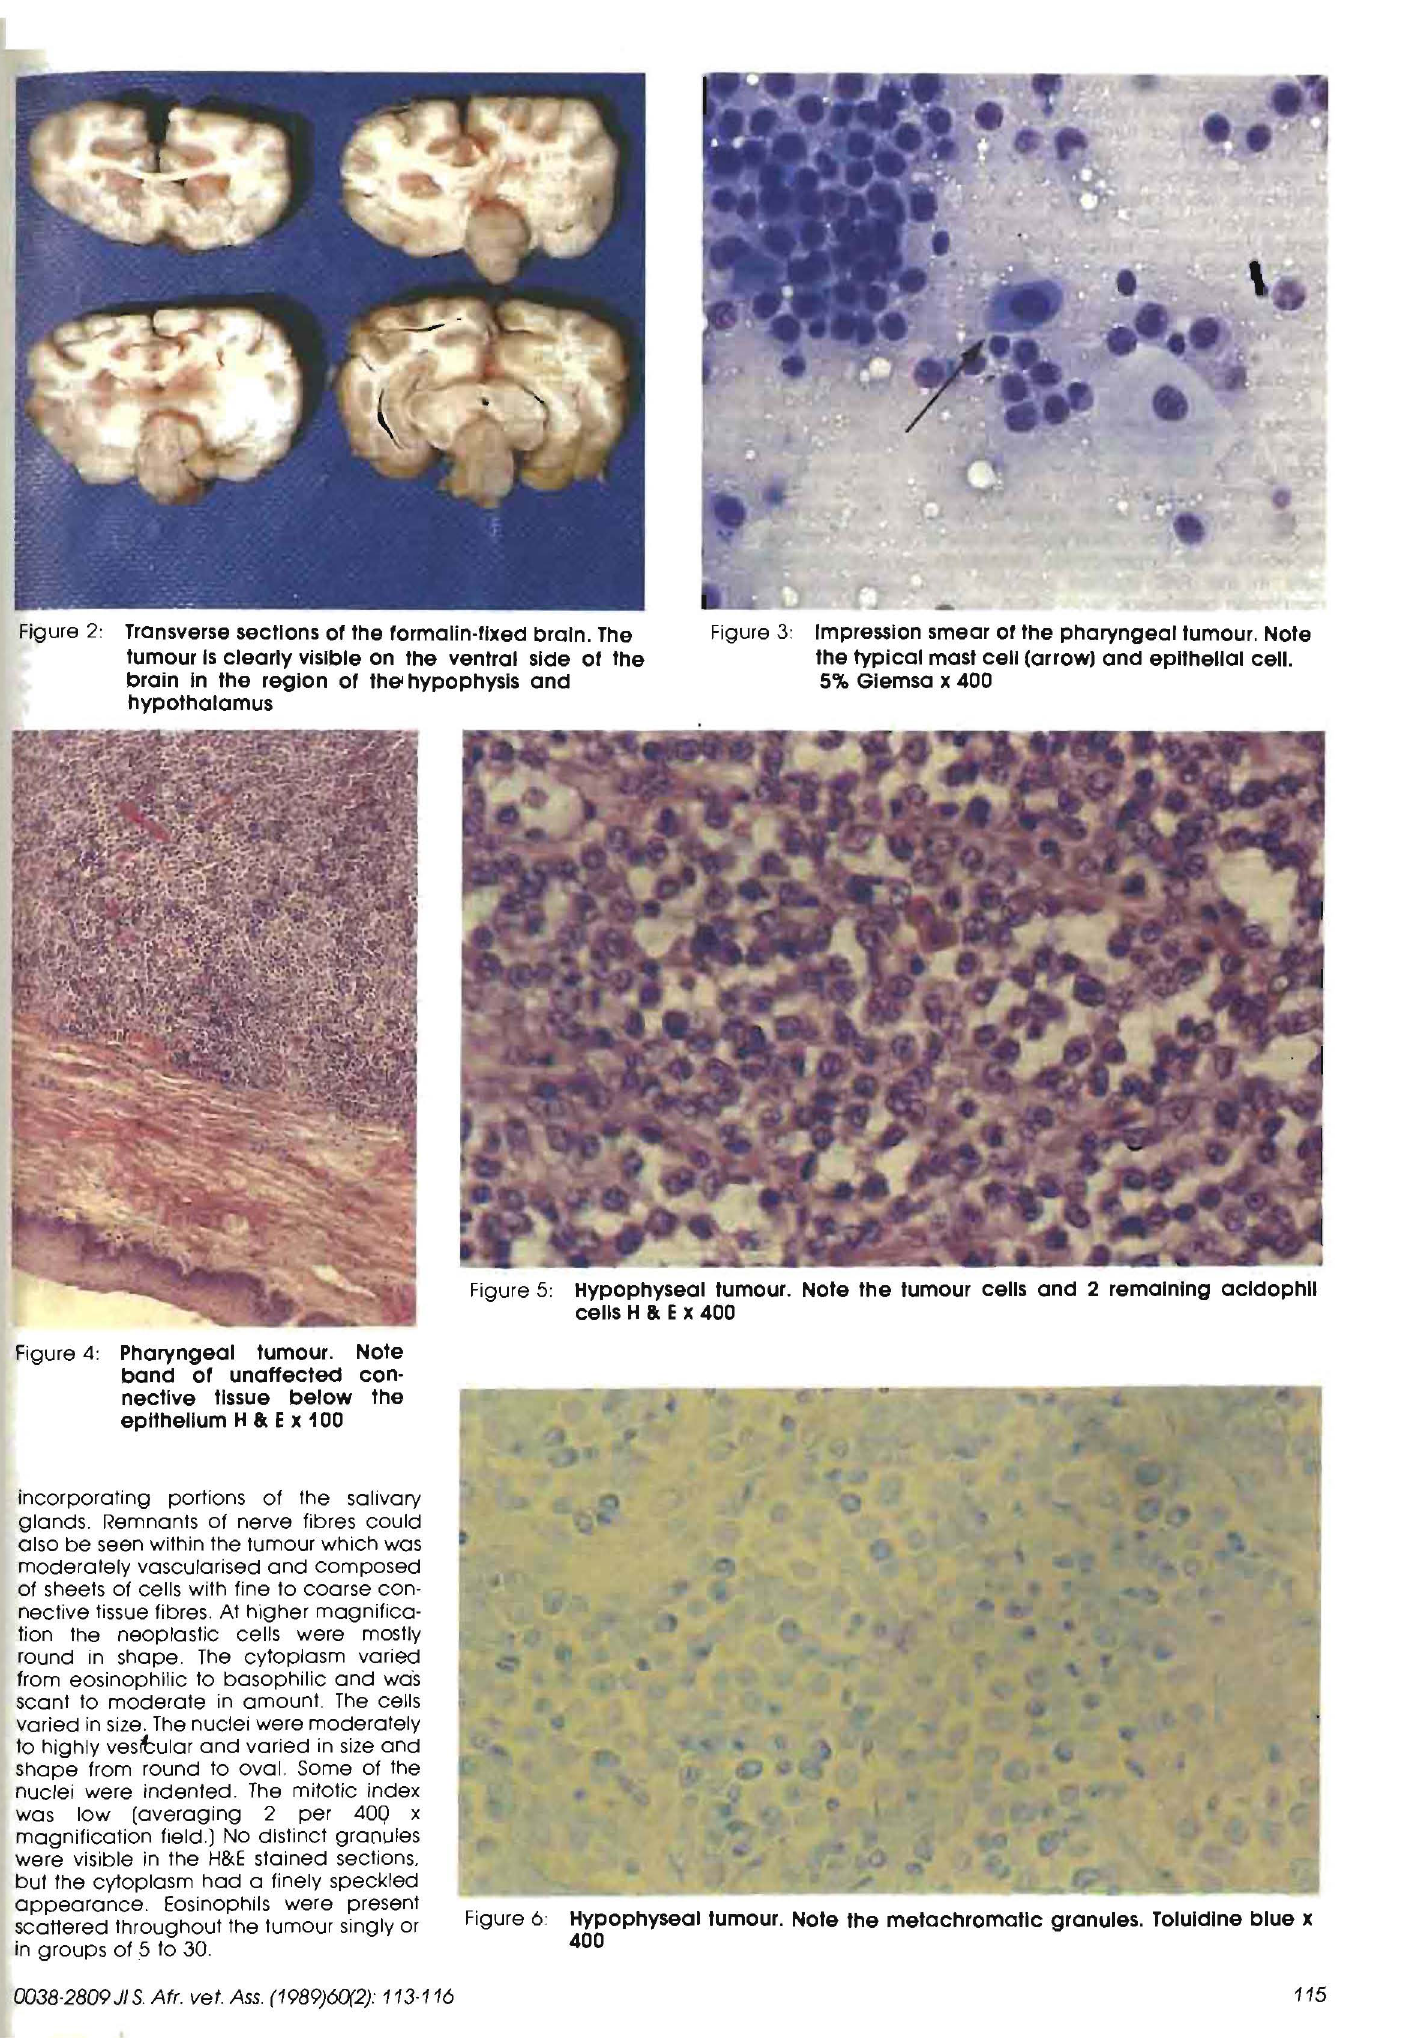
Figure 6' Hypophyseal tumour. Note the metachromatic granules. Toluidine blue x